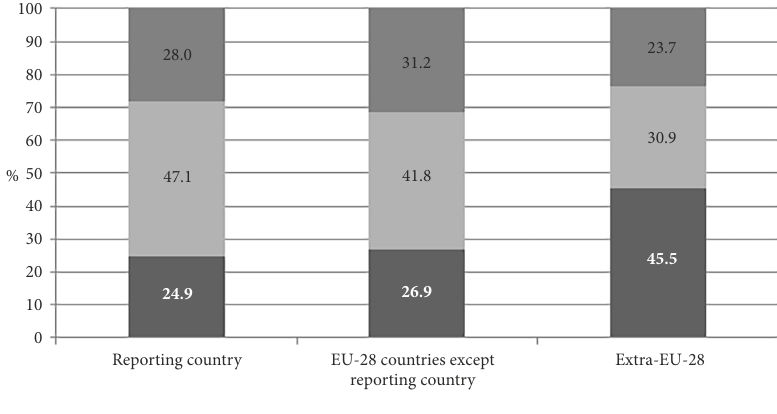
Less than primary, primary and lower secondary education (levels 0–2) Upper secondary and post-secondary non-tertiary education (levels 3 and